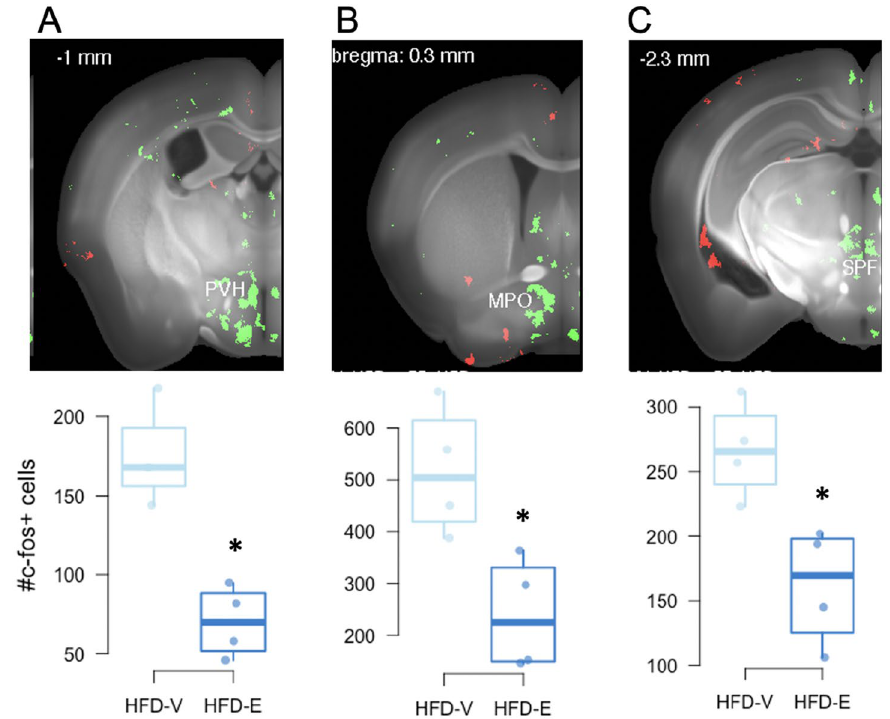
Figure 4. iDISCO reveals that estradiol reduces c-fos immunoreactivity in brain regions involved in anxiety- like behavior and energy homeostasis in HFD-fed female mice. c-fos immunoreactivity (green) in the ( A ) paraventricular nucleus of the hypothalamus (PVH), ( B ) medial preoptic area (MPO), ( C ) subparafascicular nucleus (SPF) of the thalamus (n = 4/group). Some non-specific c-fos immunoreactivity (red) is also observed. The box limits are the first and third quartiles. The whiskers are at 1.5 times the interquartile range below the first quartile and above the third quartile. *Denotes q < 0.05 between the two